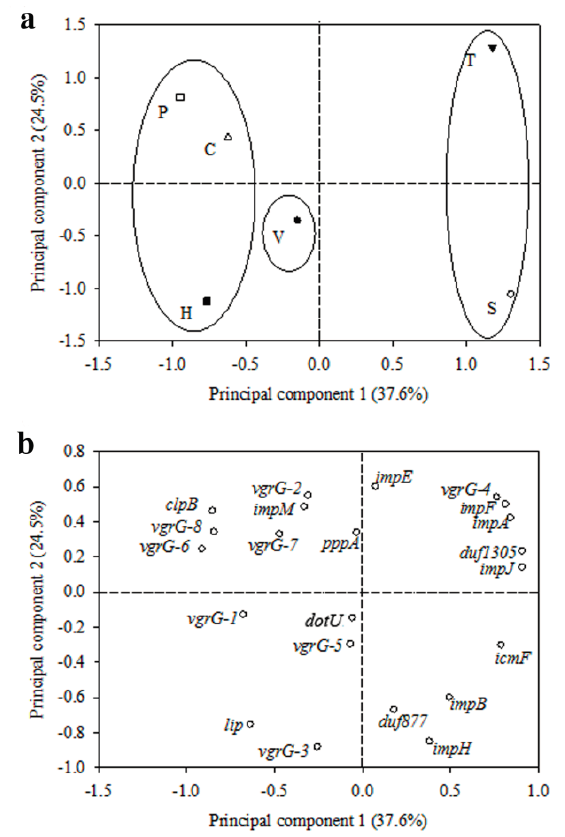
Figure 4. Two-dimensional principle component analyses (PCA) of 14 T6SS genes expression of Acidovorax avenae subsp. avenae RS-1 under 6 different